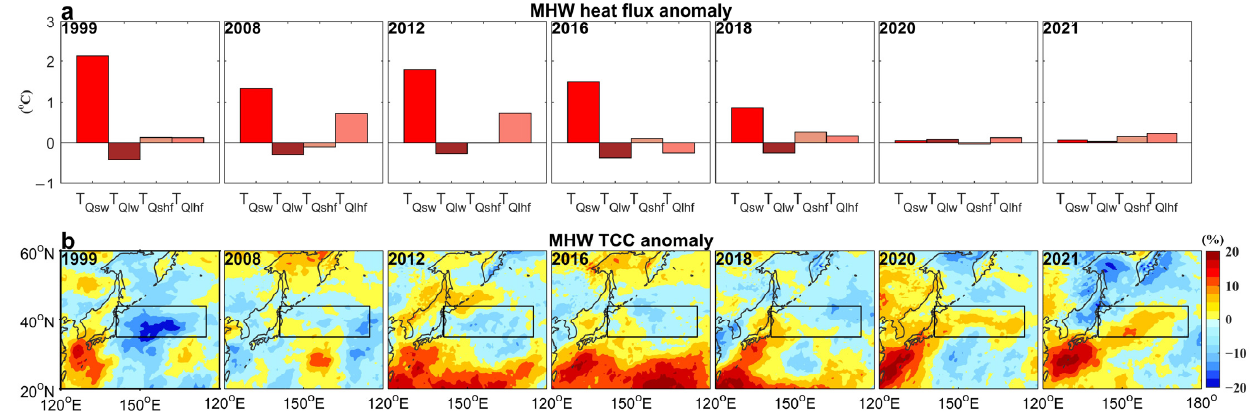
Figure 6. ( a ) Contributions from different air-sea heat flux components to the peak summer MHW temperature anomalies. ( b ) The JAS averaged TCC anomalies during the MHW years. In ( b ), the areas framed by the black dashed lines denote the KOE domain.